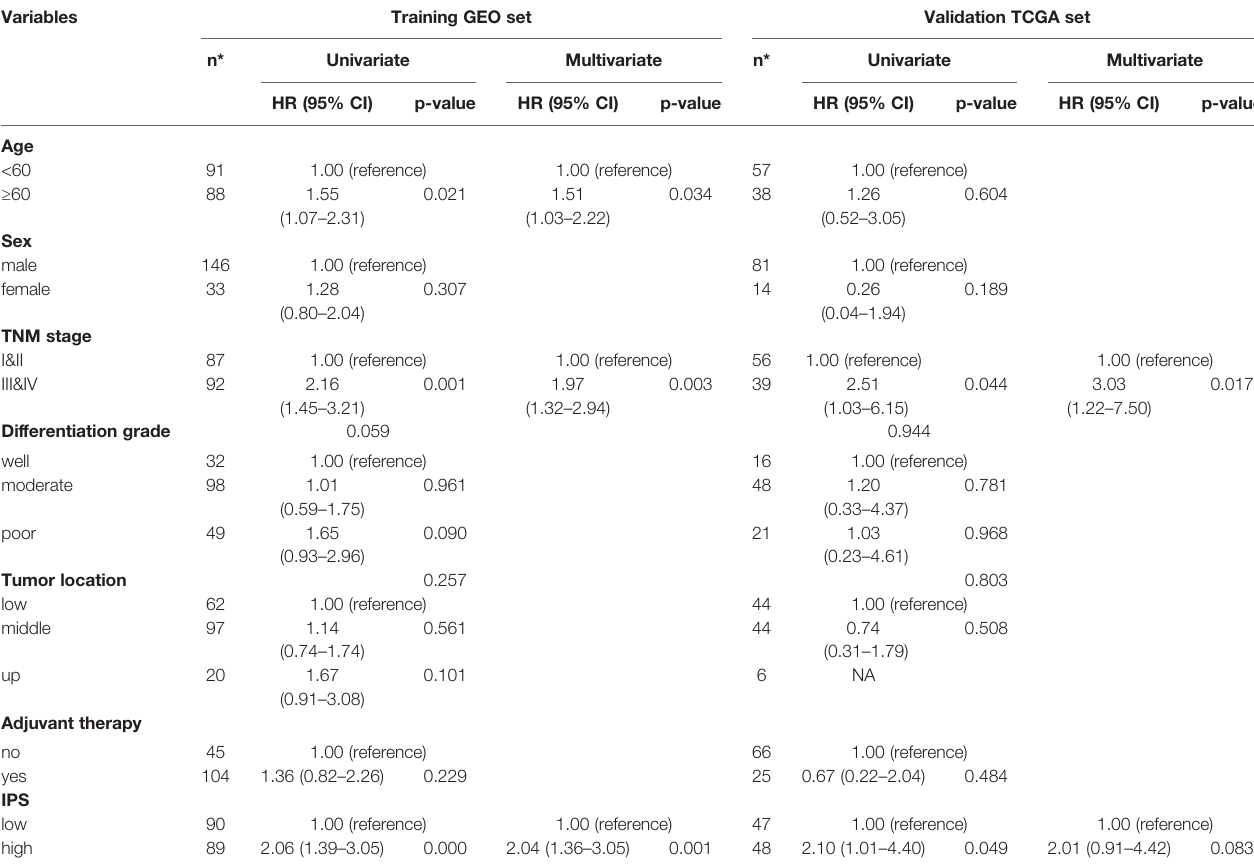
TABLE 1 | Univariate and multivariate Cox regression analyses for overall survival in the GEO training set and TCGA validation